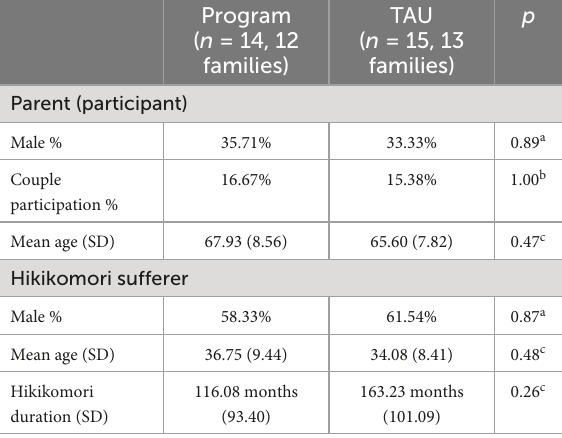
TABLE 2 Baseline demographics of participants and hikikomori